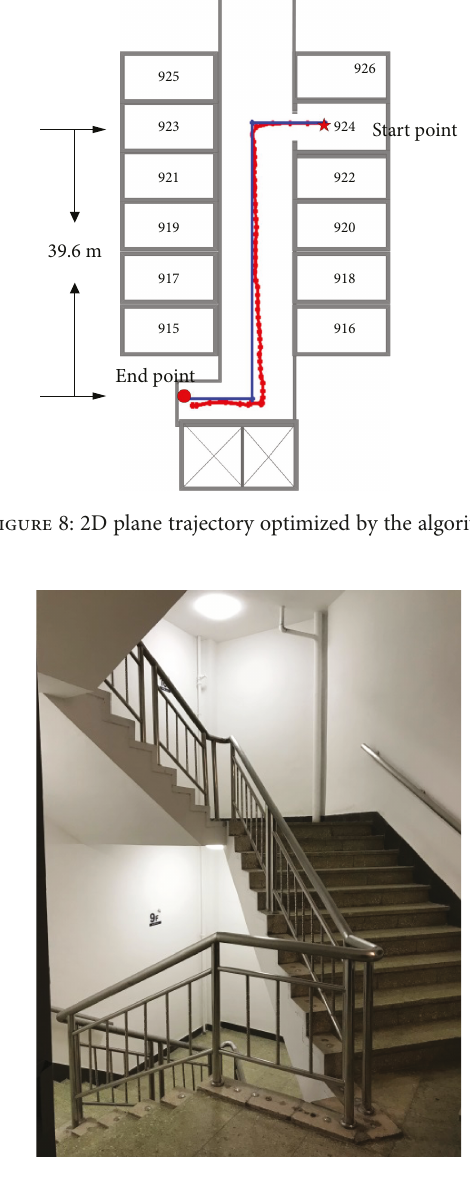
Figure 9: Experimental environment in Case